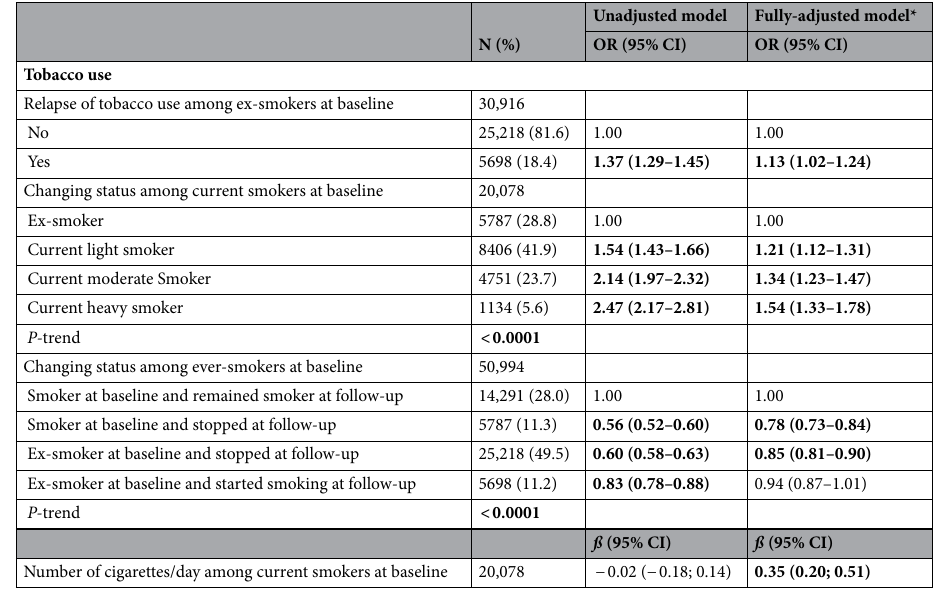
Table 2. Association between high physical exertion at work and tobacco use at 1-year of follow-up among employees in the CONSTANCES cohort study, 2012–2018 (odds ratios (ORs), and 95% confidence intervals, CI). Categories of current smokers were defined as: light smokers (< 10 cigarettes/day), moderate smokers (10– 18 cigarettes/day) and heavy smokers (> 19 cigarettes/day). Relapse was defined as: no (remained non-smokers